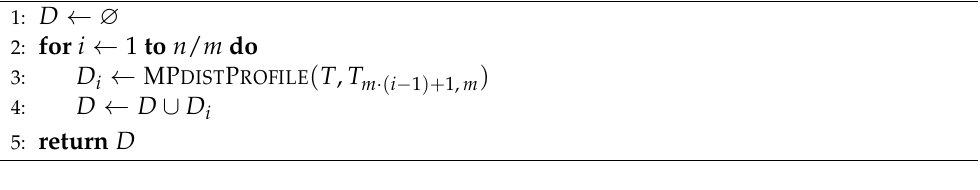
Algorithm 2 G ET A LL P ROFILES ( IN T , m ; OUT D )